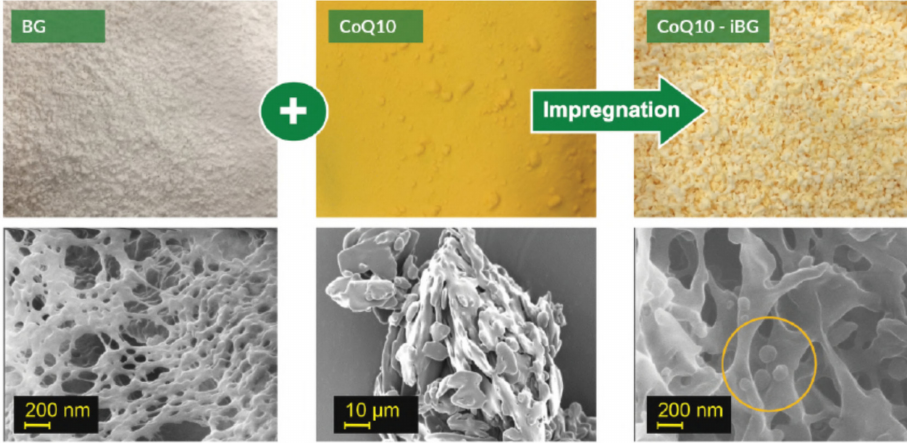
Figure 8. Processed oat beta glucan (BG) by PGX with the addition of the co-enzyme Q10 to produce an encapsulated ingredient (CoQ10-iBG)